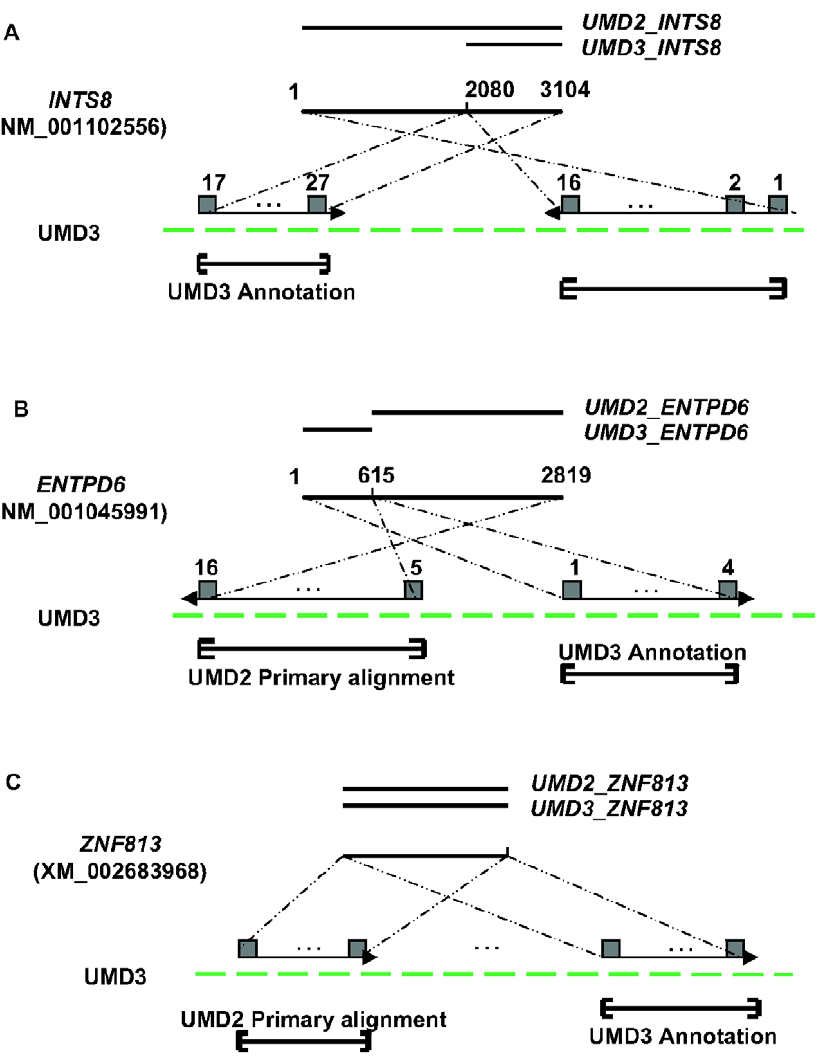
Figure 3. Examples showing how the same gene annotated on two assemblies completely fails to overlap. A) The alignment of the RefSeq DNA sequence for INTS8 spans the entire gene on UMD2, but is truncated on UMD3. The figure shows how the INTS8 sequence aligns to two distinct locations on UMD3, a longer, primary alignment containing exons 1–16 and a shorter one containing exons 17–27. The annotation system chose the shorter alignment (on the left) for the UMD3 annotation, which is thus disjoint from the primary alignment of the UMD2 annotation of INTS8. B) The gene ENTPD6 is fragmented in both assemblies, and different segments were used by the annotation software in each case. Again, the primary alignment on UMD3 and the local annotation are distinct. C) The gene ZNF813 has multiple matches on UMD3, but the best match and the annotated gene are disjoint.